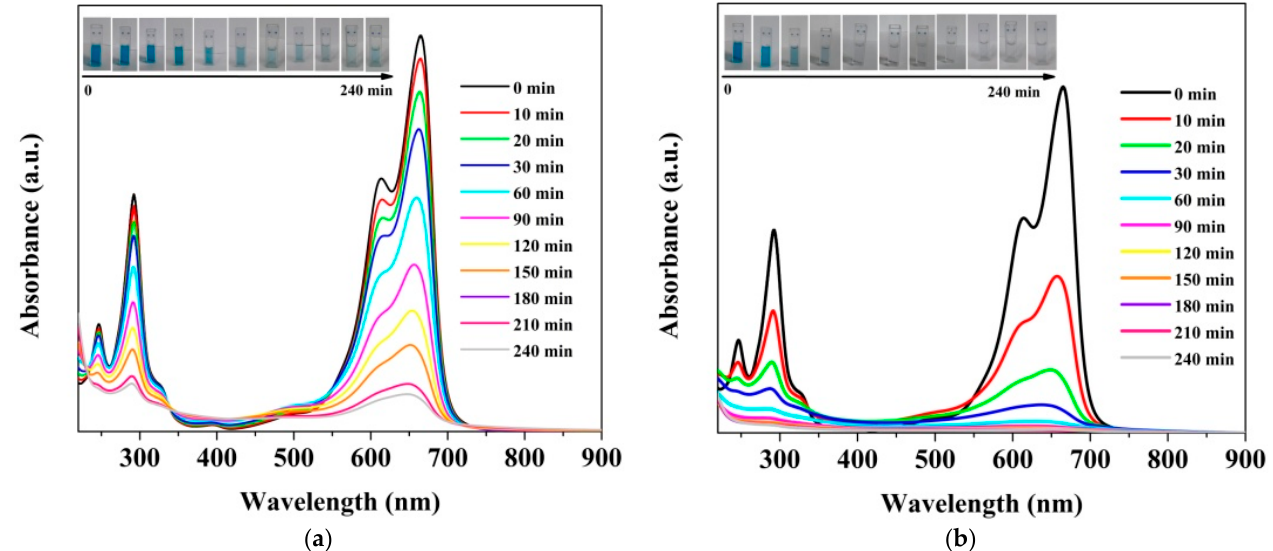
Figure 5. ( a ) UV-Vis-absorption spectra of MB dye as a function of irradiation time acquired in the presence of flower-like, nanostructured ZnO thin film, synthesized by DC-TVA ( a ) and PTVA ( b ), respectively. The inset photos show the colour change of dye solutions during